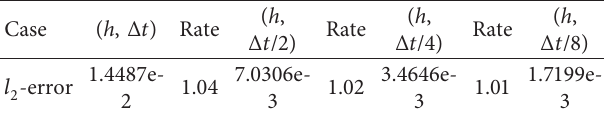
Table 5: Convergence test results of the fully implicit method for time